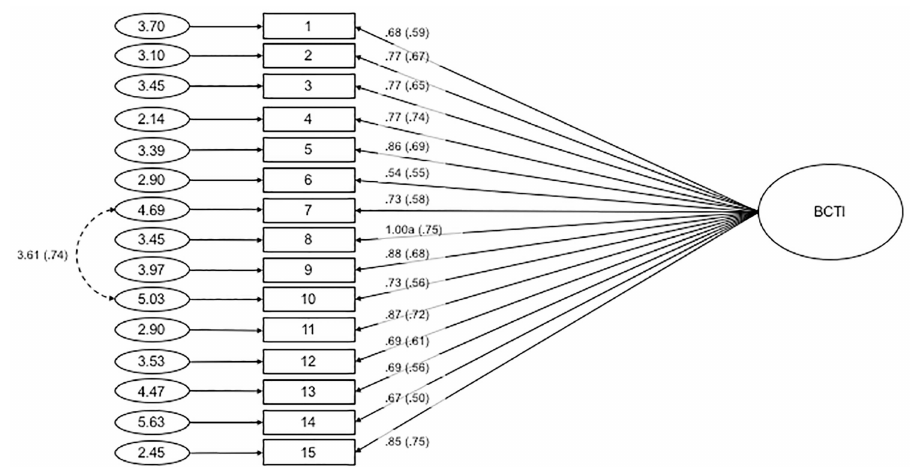
Fig 1. Path diagram and estimatesfor the Belief in Conspiracy Theories Inventory. Item numbersin the figure reflect the item numberin Table 4. The large circle is the latent construct, with the rectangles representing measured variables, and the small circles with numbers are the residualvariables(variances). The factor loadingsare standardised in parenthesises, and the unstandarised values outside, with both being reportedfollowingthe guidelinesof Kline [42]. Significance levels were determinedby critical ratios (all p < .001). The factor loadingswere fixed at the indicatedvalue